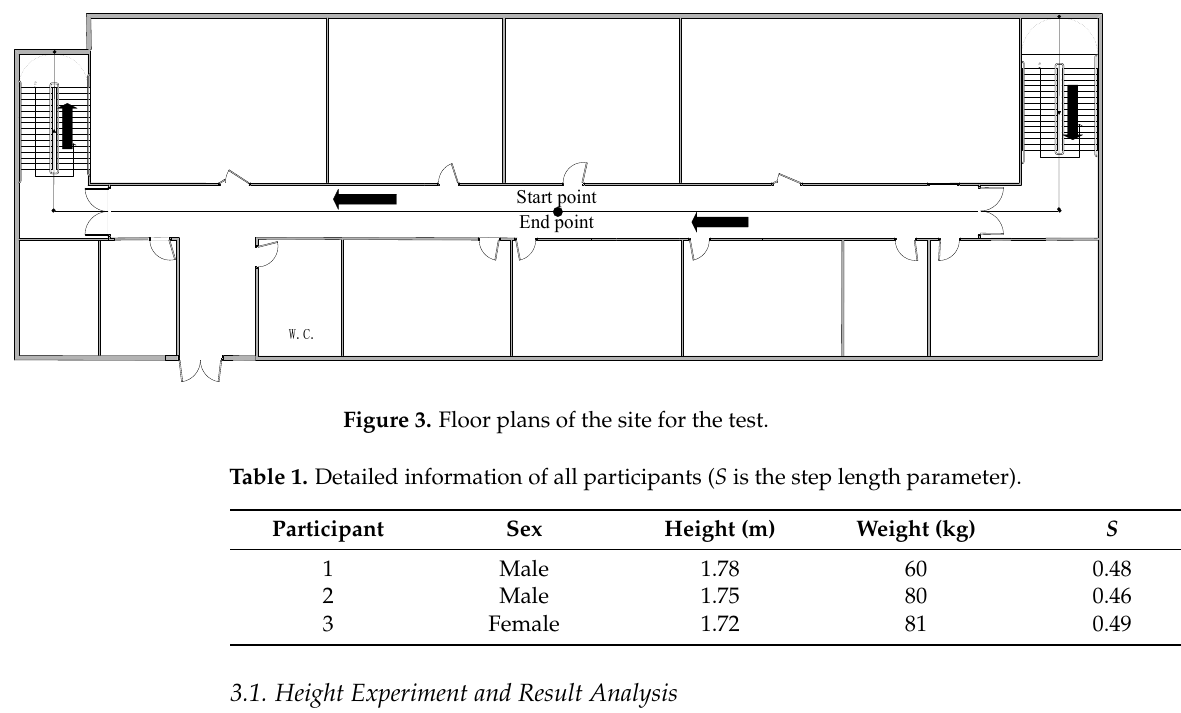
Table 1. Detailed information of all participants (S is the step length parameter).